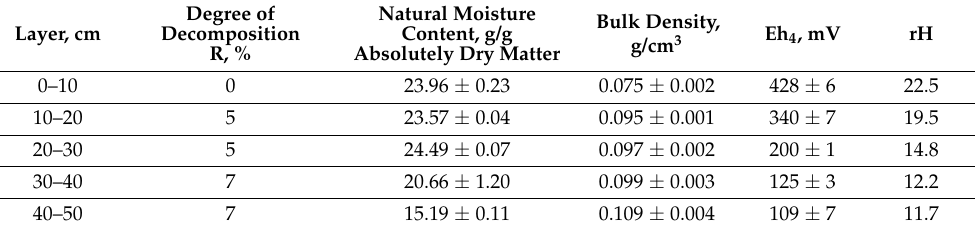
Table 1. Change in the degree of decomposition, natural moisture content, bulk density, ORP (Eh 4 ), and the rH-index of peat by depth.